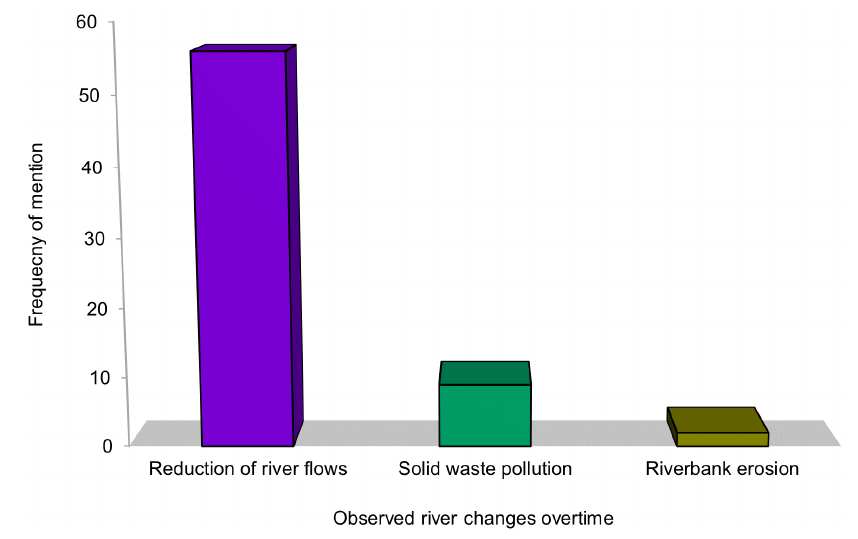
Figure 7. Observed changes in both study sites in the Beas River overtime.